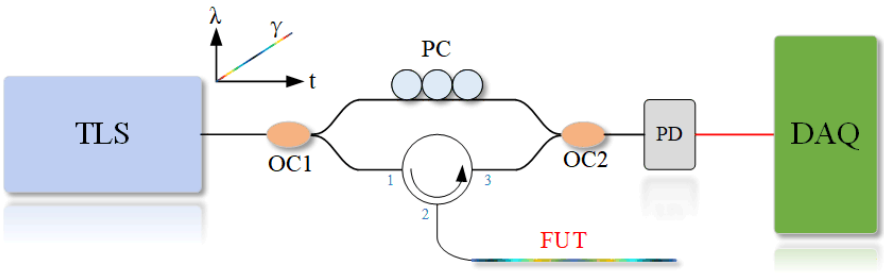
Figure 1. Schematic diagram of the sensing system based on optical FMCW interferometer. TLS: tunable laser source; OC: optical coupler; PC: polarization controller; PD: photodetector; DAQ: data acquisition card; FUT: fiber under test .